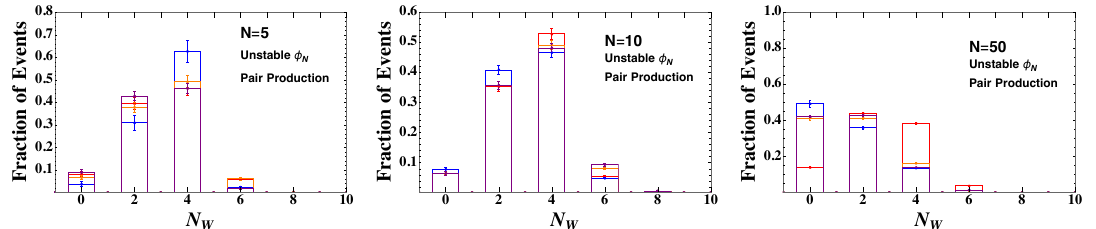
Figure 12. Total number of b -jets in the event for the Z in eqs. (3.1) and (3.2). Di(cid:11)erent colors correspond to di(cid:11)erent spectra. From left to right: N =5, 10, and 50 scalars in the new sector.